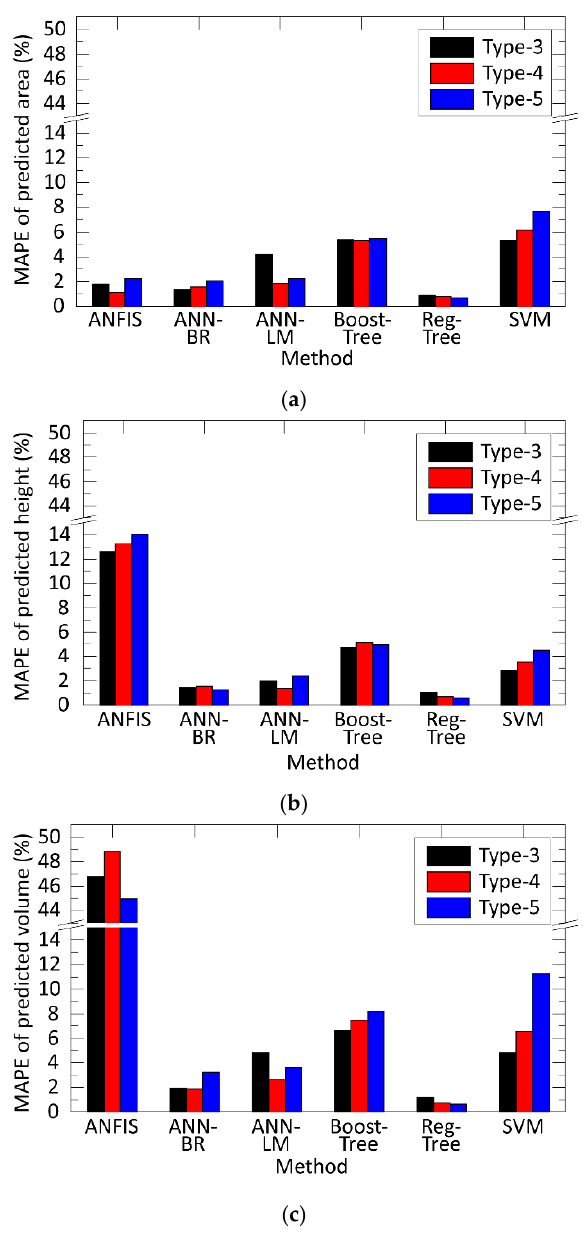
Figure 10. Comparing the prediction error as a function of the paste-type (particle size): ( a ) error for the printed height; ( b ) error for the printed area; ( c ) error for the deposited paste volume.